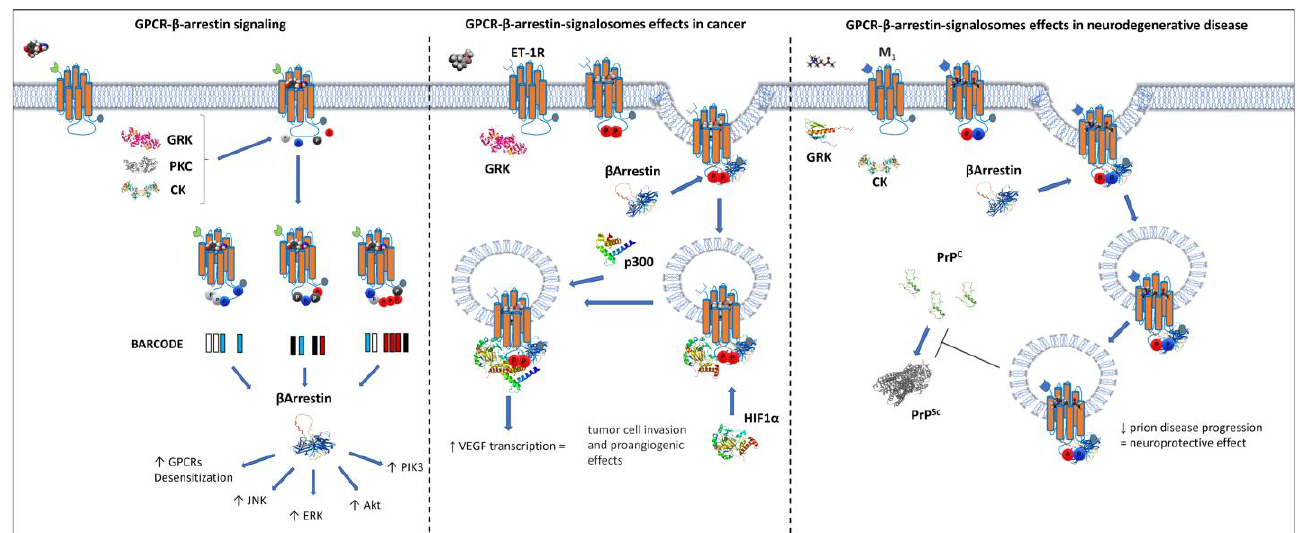
Figure 2. GPCR/β -arrestin-dependent signaling pathway. GPCRs are illustrated as orange trans- membrane proteins whose carboxyl groups are shown as gray dots and their N-terminal groups as differently shaped symbols. GPCR phosphorylation processes can take place through the action of GPCR kinases (GRKs) or casein kinase (CKs), represented with red and blue dots, respectively. β -arrestin functions are to reduce GPCR coupling to G proteins, favor the internalization of the recep- tor in endosomes and signal through the GPCR- β -arrestin complex to promote JNK, ERK, phospho- inositide 3 kinase (PIK3), and Akt signaling. Different degrees of GPCR phosphorylation affect the interaction between receptor and β -arrestin, thus initiating preferential intracellular responses such as β -arrestin mediating ERK, JNK, or GPCR desensitization (barcode theory). In cancer cells, these GPCR –β -arrestin-dependent multiprotein complexes interact with signaling proteins involved in gene transcription: in ovarian cancer, the activation of ET-1R promotes the interaction between β -arr1/p300 and HIF- 1α, enhancing the transcrip tion of genes, such as ET-1 and VEGF, required for tumor cell invasion and proangiogenic effects. Meanwhile, in neurodegenerative disease, GPCR –β -arrestin signalosomes exert a crucial neuroprotective effect as shown in the right part of the figure, where the complexed, internalized muscarinic M 1 receptor signaling reduces the accumulation of misfolded prion protein (PrPsc).